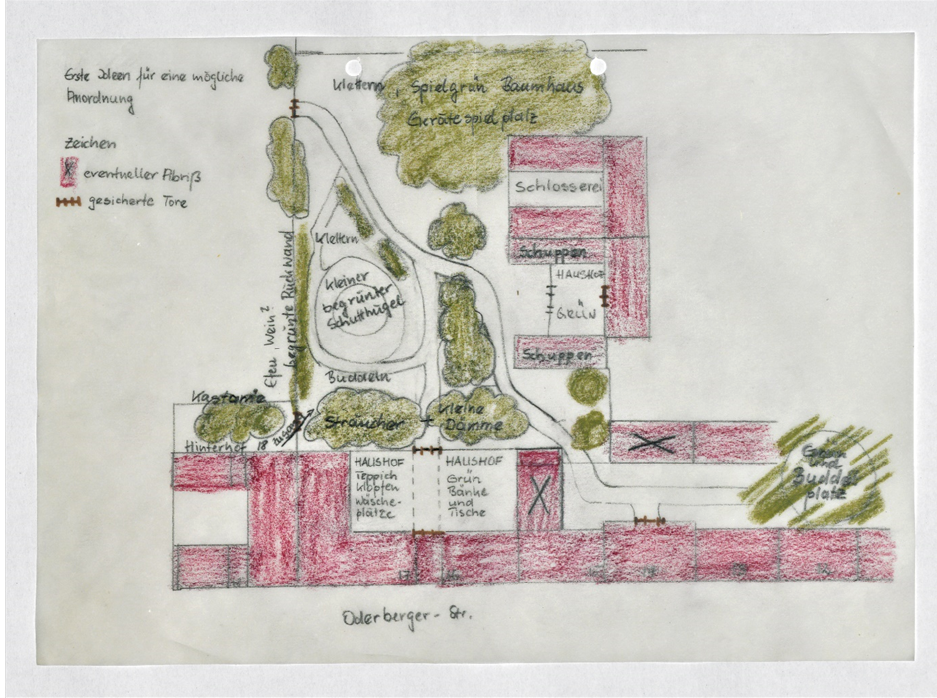
Figure 2. Draft of the conversion map drawn by the neighbourhood initiative of Oderberger Street 15/17. Source: “Eingabe zum Bauvorhaben Tischlerei/Kinderspielplatz auf dem Gelände hinter den Häusern der Oderberger Str. 15–18” (1981). Image rights: Landesarchiv